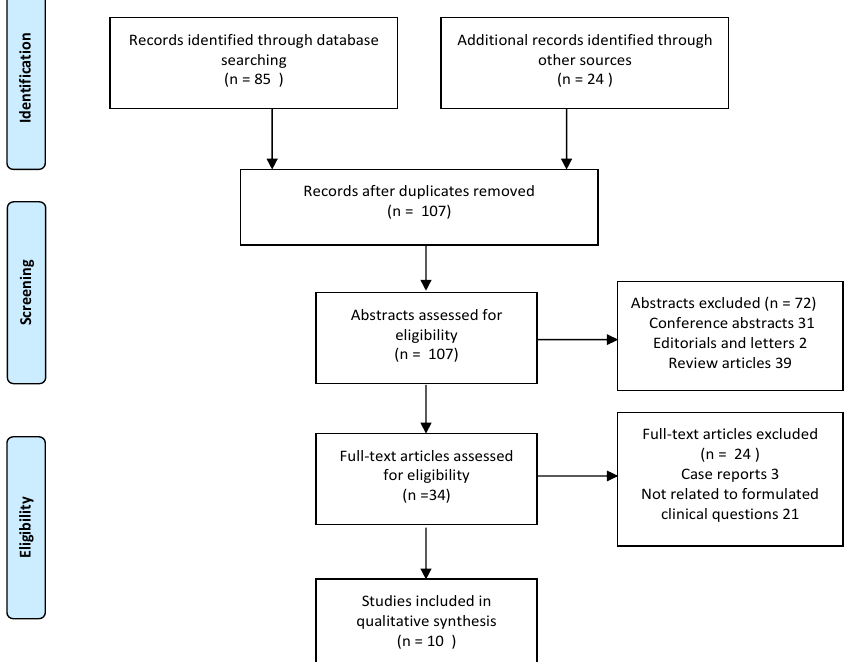
Figure 1. Flowchart detailing the selection of studies for the analysis.